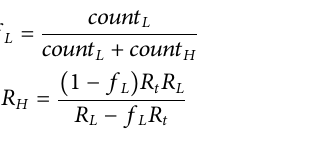
Frontiers in Earth Science |